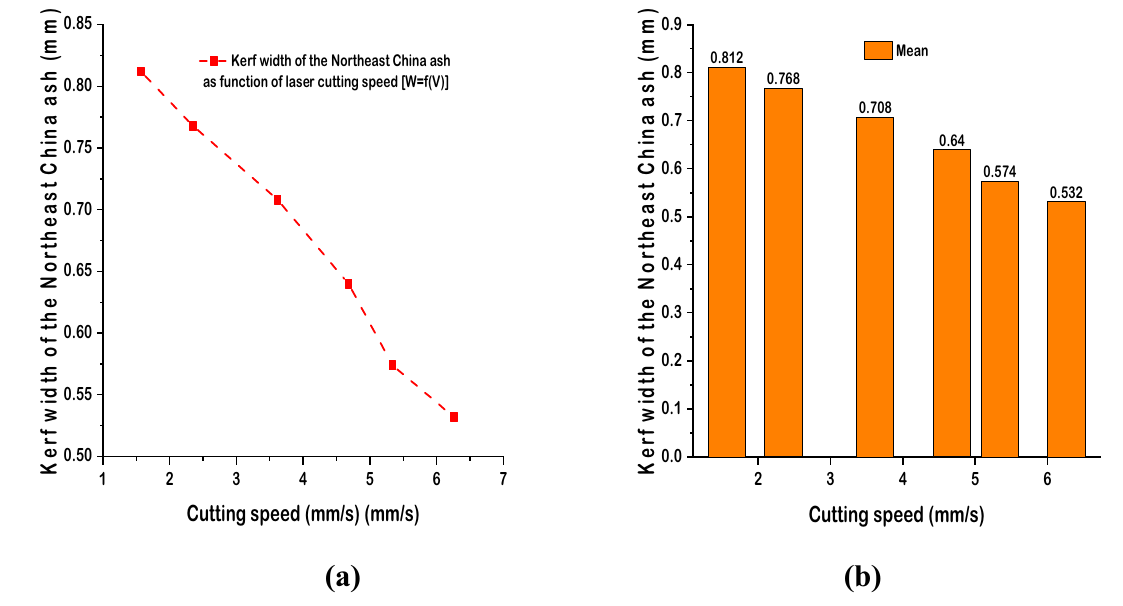
Fig. 15 Kerf width of Northeast China ash as a function of cutting speed [ W = f (V) ] a Kerf width variation of Northeast China ash, b Histo- gram of kerf width versus laser cutting speed